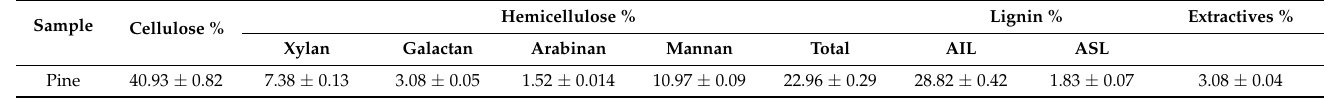
Table 2. Results of component analysis, wt %, dry